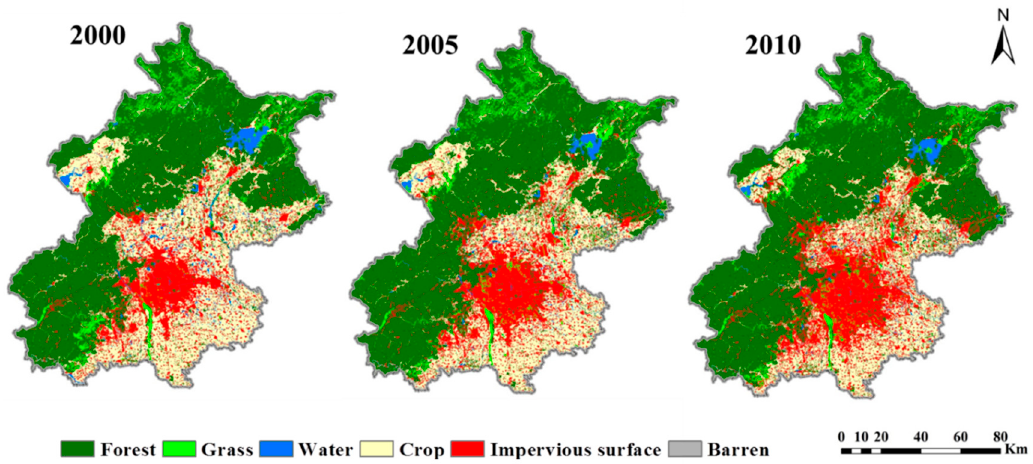
Figure 2. Land use and land cover of Beijing in 2000, 2005, and 2010.